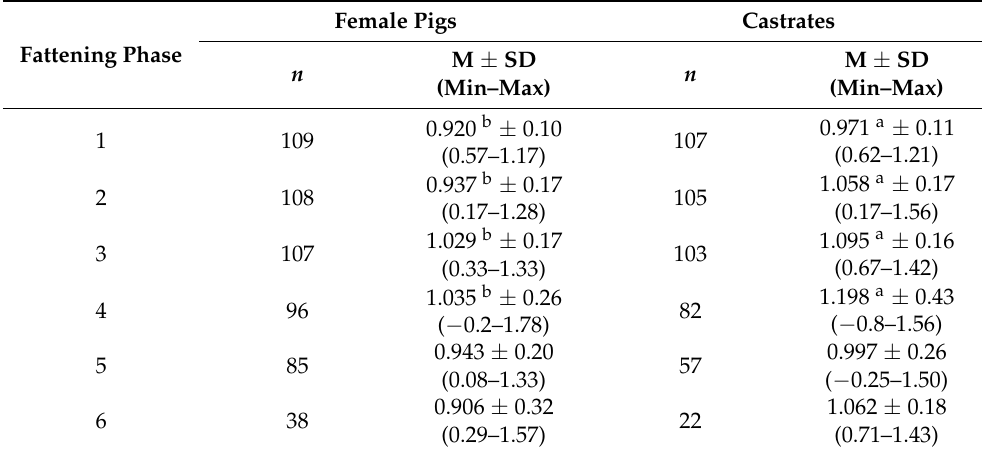
Table 6. Weight gain of pigs (kg/animal/day) during the fattening period.